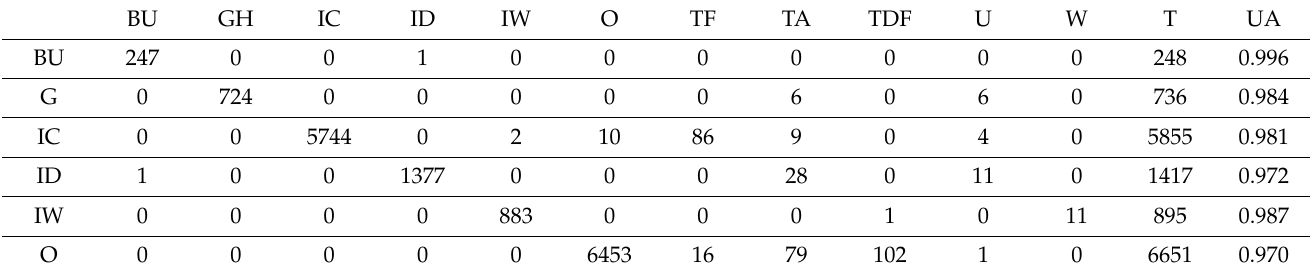
Table A4. Error matrix for accuracy assessment of the classification in 2022 using random